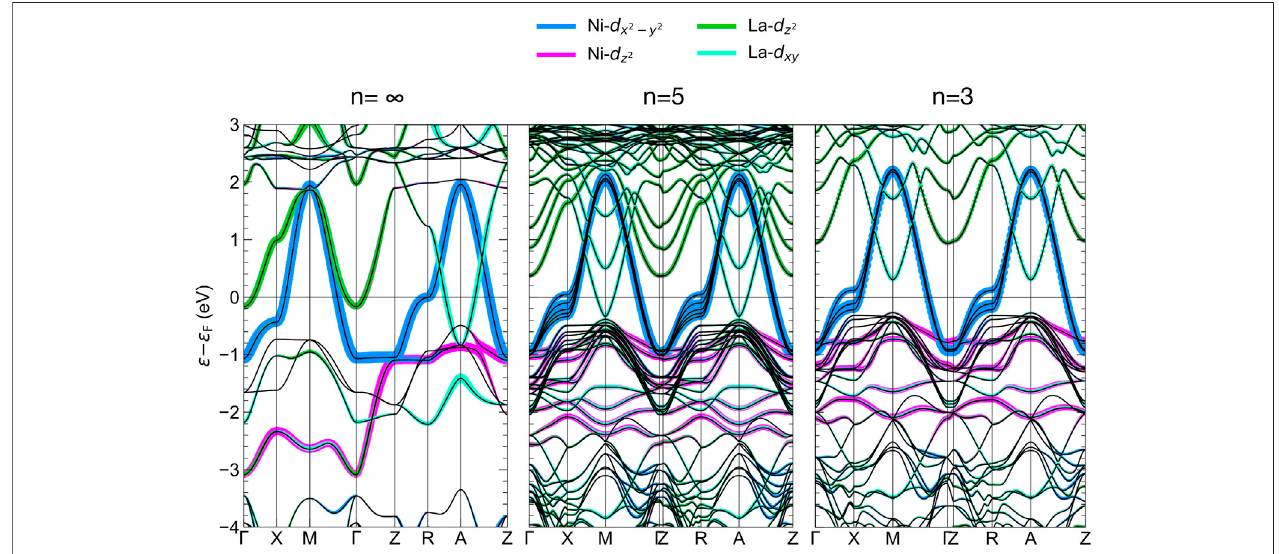
FIGURE2| DFTbandstructuresintheparamagneticstateforthe n (cid:1) ∞ , n (cid:1) 5,and n (cid:1) 3layerednickelates.ThetwotypesofNi e g bandsarehighlighted,aswellas the two relevant R -5 d bands (La is used as an example). It can be observed how the involvement of R -d bands around the Fermi level is reduced with decreasing n .